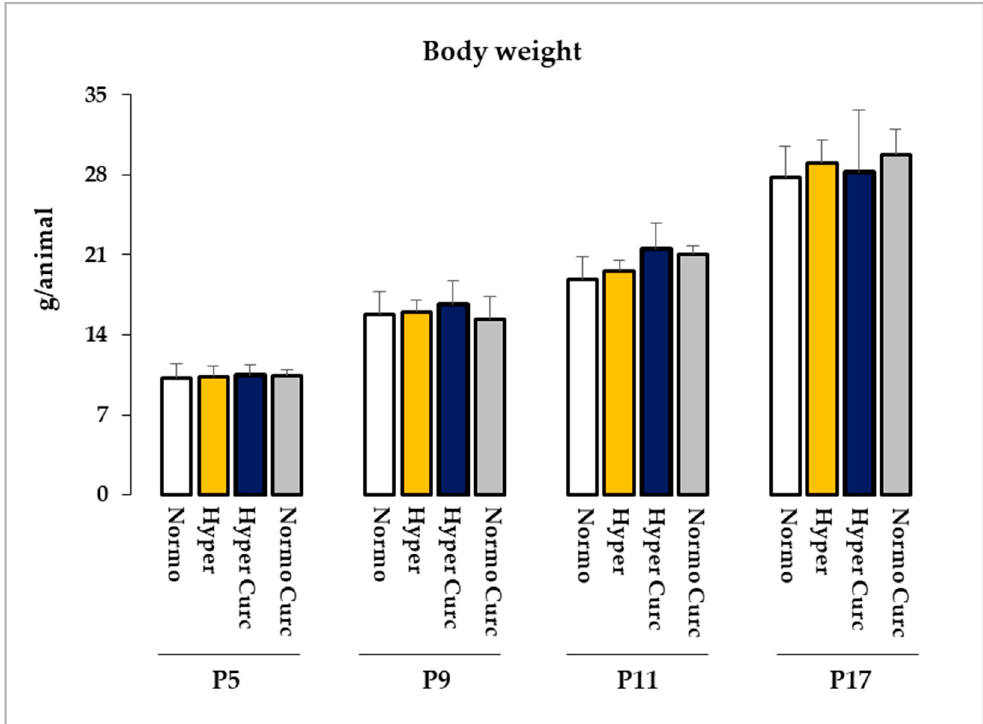
Figure 4. Bodyweight recording. Bodyweight in developing Gunn rats is expressed as mean ± S.D., and as g/animal. P: post-natal age in days. With white bars—untreated normobilirubinemic (Normo) Gunn pups; yellow bars—untreated hyperbilirubinemic rats (Hyper); blue bars—curcumin treated hyperbilirubinemic pups (Hyper Curc), grey bars—Curc treated Normo rats (Normo Curc). In each experimental group, ≥ 10 animals were studied. No statistical differences were noticed.